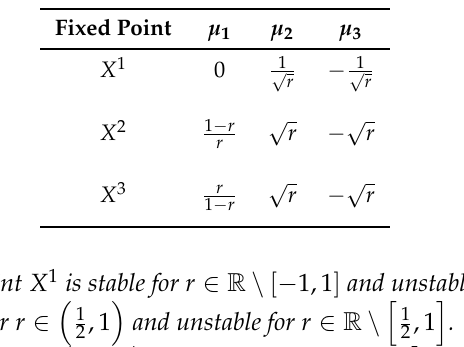
Table 1. The eigenvalues of the Jacobian matrix (Equation